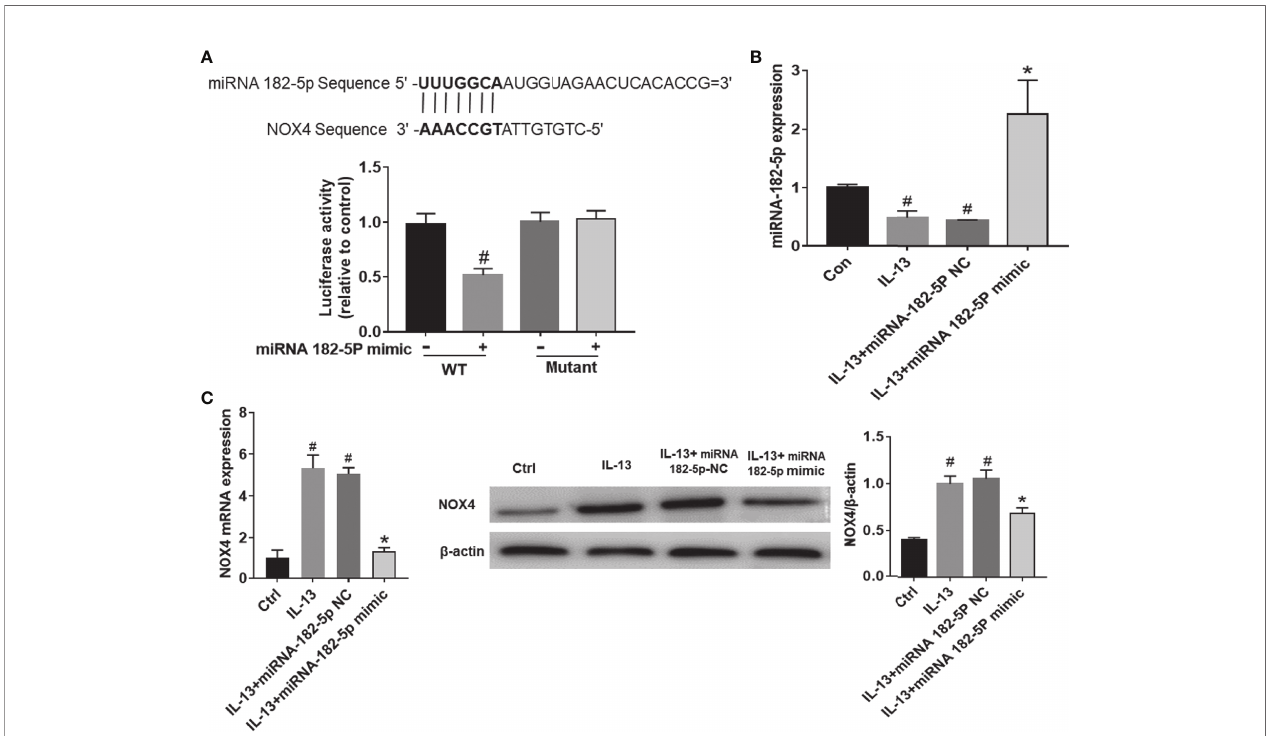
FIGURE 4 | MiRNA-182-5p targets NOX4. (A) Prediction of binding sites. WT and mutant plasmids were co-transfected with miRNA-182-5p mimic or miRNA NC for dual-luciferase assay. # p < 0.05 versus wild-type control. (B) After transfection with miRNA-182-5p mimic, real-time PCR detected miRNA-182-5p expression. (C) After transfection with miRNA-182-5p mimic or NC, real-time PCR and Western blot were used to determine NOX4 mRNA and protein expression; All data were shown as mean ± SD (n = 3). # p < 0.05 versus control, * p < 0.05 versus IL-13 group as determined by one-way analysis of variance (ANOVA) and Dunnett ’ s post hoc